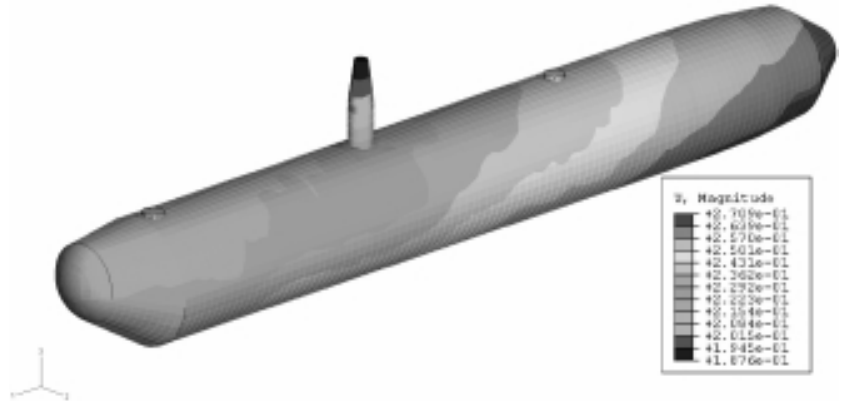
Fig. 15. Deformation distribution at t = 0.20